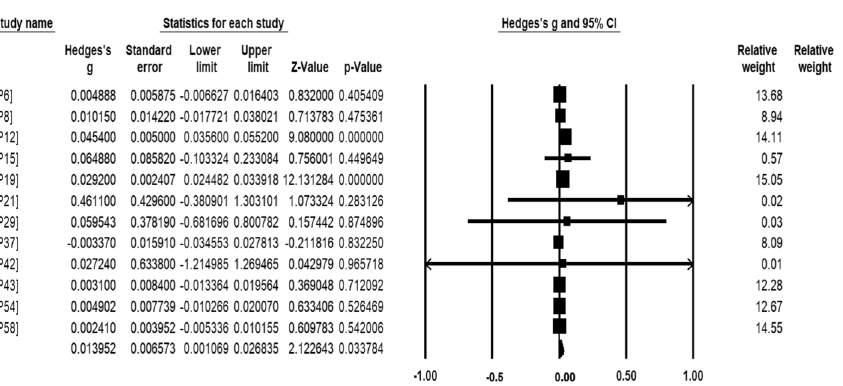
Fig. 6 Results of meta-analysis based on MAE as Hedge’s g and RMSE as Standard error